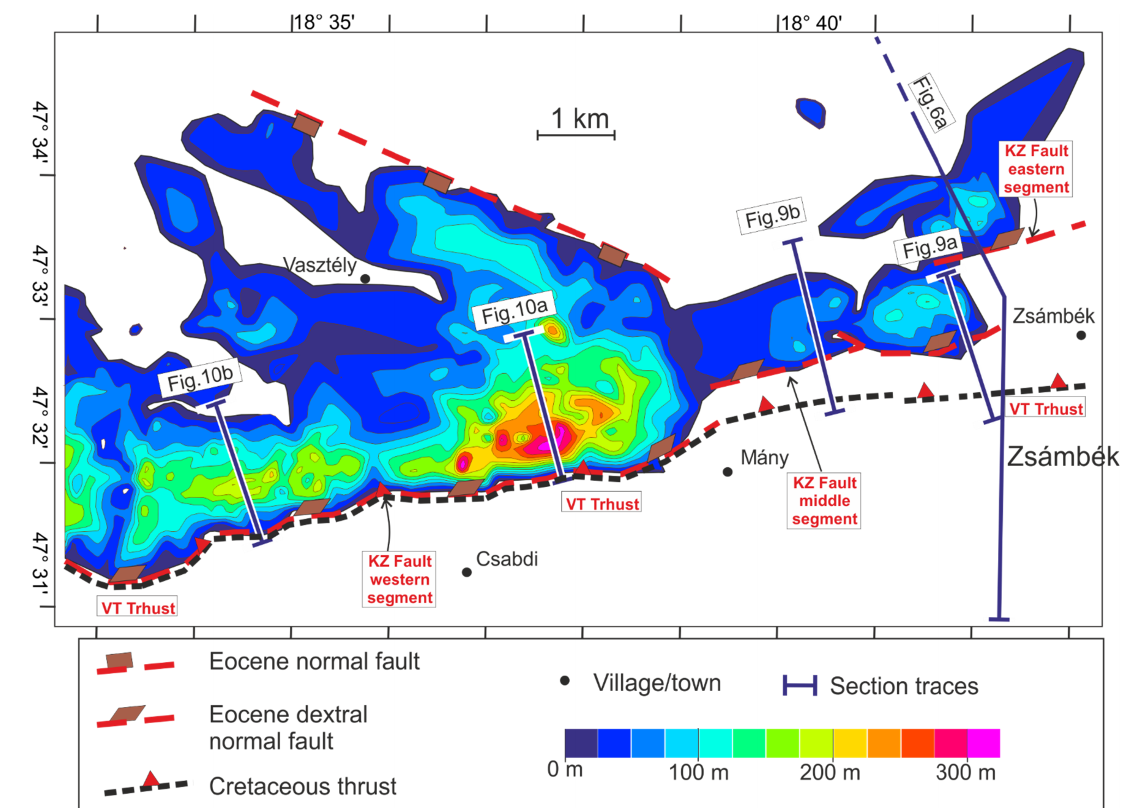
Figure 8. Eocene thickness map of the study area. Eocene sediments were not preserved in white areas. The KZ Fault and the VT Thrust are illustrated by the cut-off line of these faults and the base-Oligocene horizon. Therefore the traces of these faults differ in Figures 7 and 8. For the location of the map within the Zsámbék–Mány Basin, see Figure 4. The abbreviations “Fig.” refer to figures of this work.